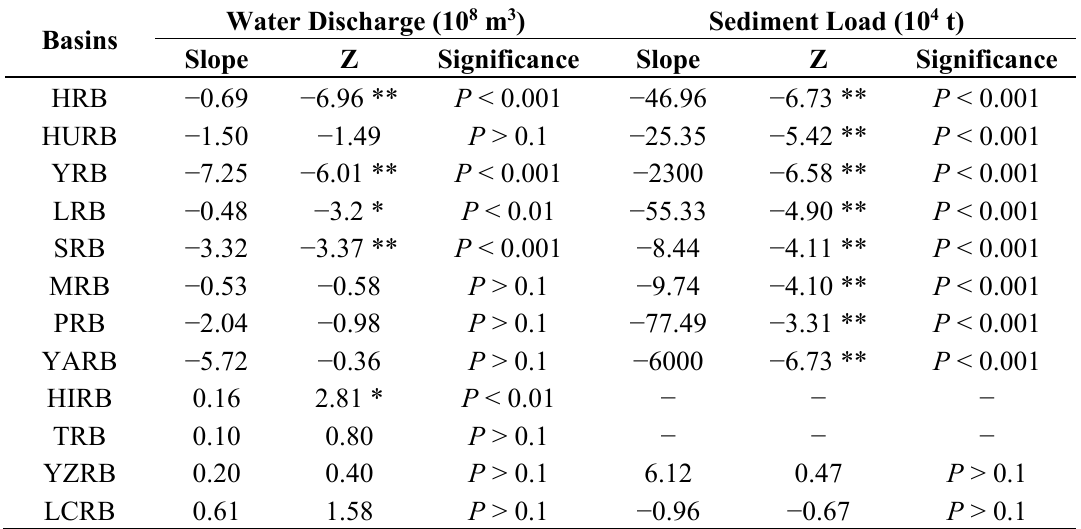
Table 4. Results of Sen’s slope estimator and the Z value by using linear regression and the Mann–Kendall test,